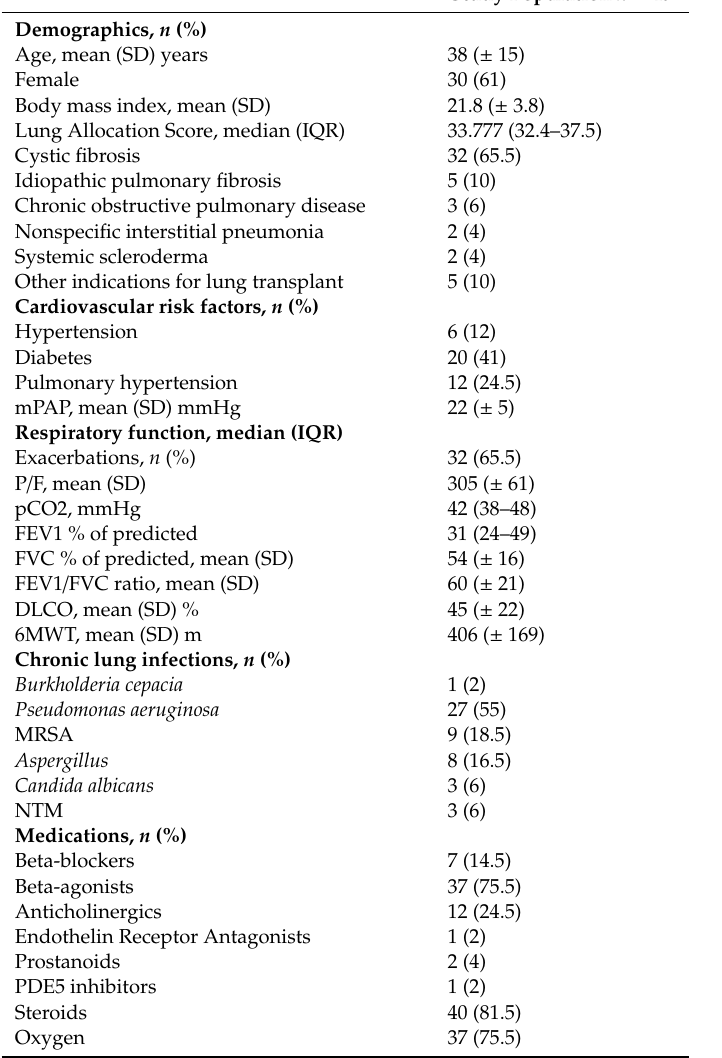
Table 1. Demographics, cardiovascular risk factors, respiratory function, chronic lung infections, and medications of patients on the lung transplant